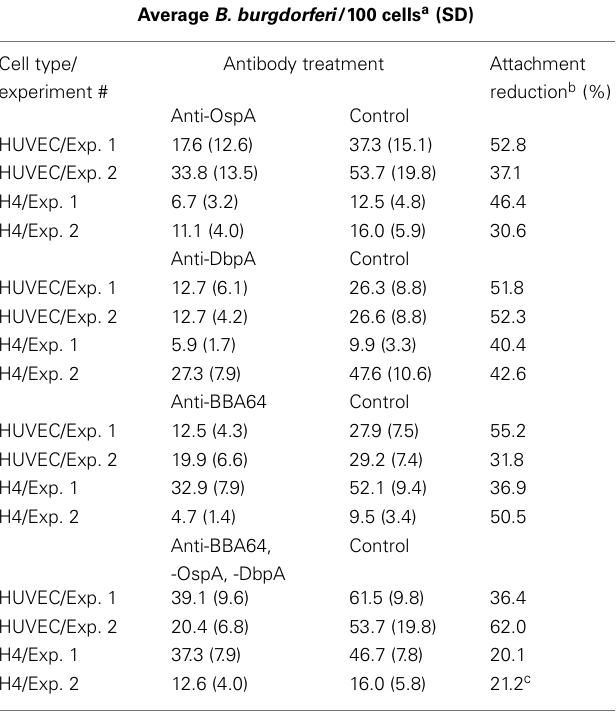
Table 1 | Reduction in B. burgdorferi binding to HUVEC and H4 cells following treatment with anti- B. burgdorferi surface protein antibodies.